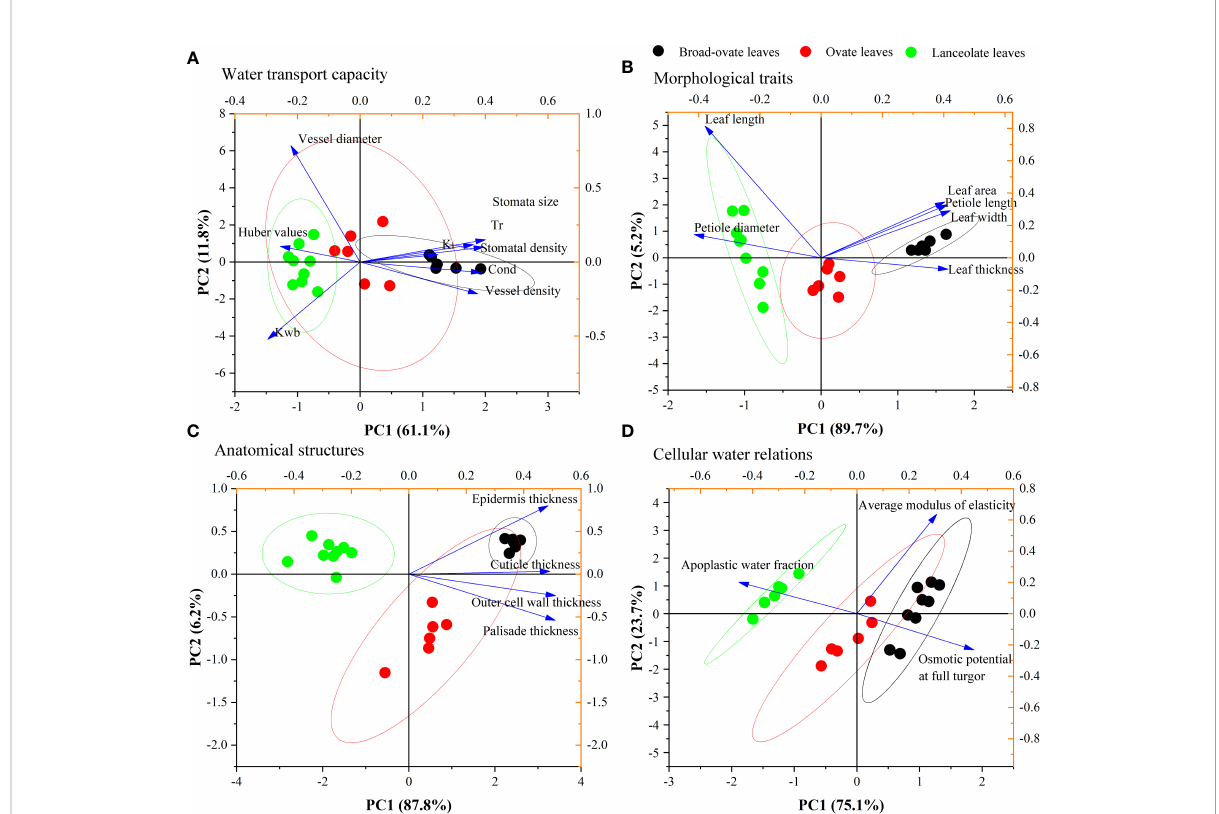
FIGURE 6 PCA results of water transport capacity, morphological traits, anatomical structures, and cellular water